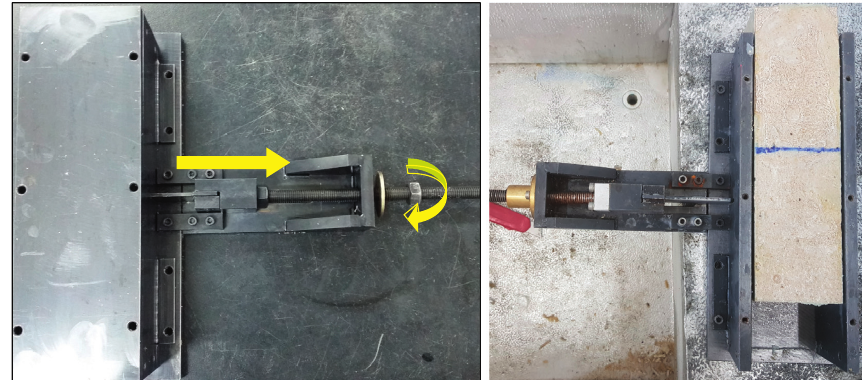
Figure 7: Device to make notch and frozen specimen with the notching